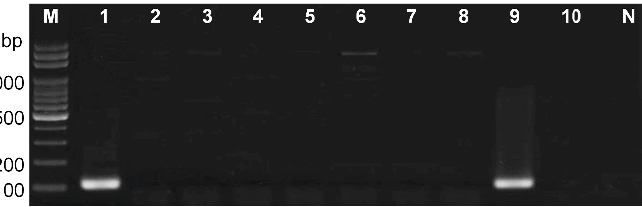
Figure 4. PCR discrimination of Infantis from seven other serovars by means of the proposed diagnostic primer set. PCR with the usg -specific primers was applied to S . Infantis strain CCARM 8283